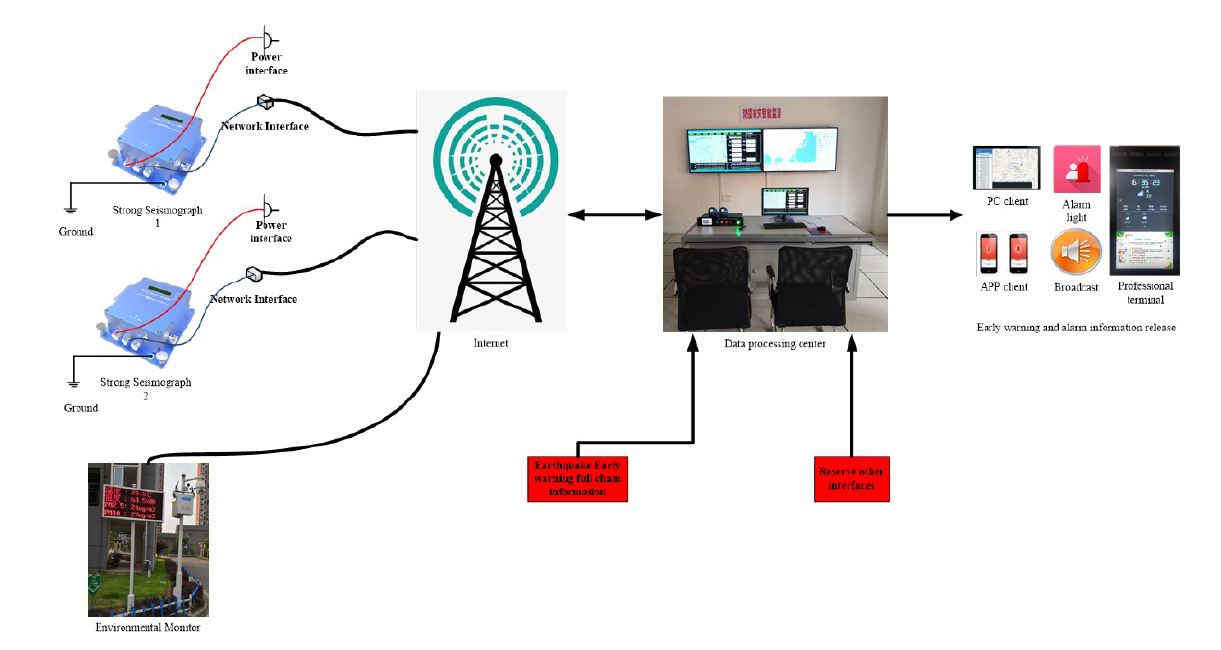
Fig. 2 Overall architecture of the Xinheyuan Smart Community